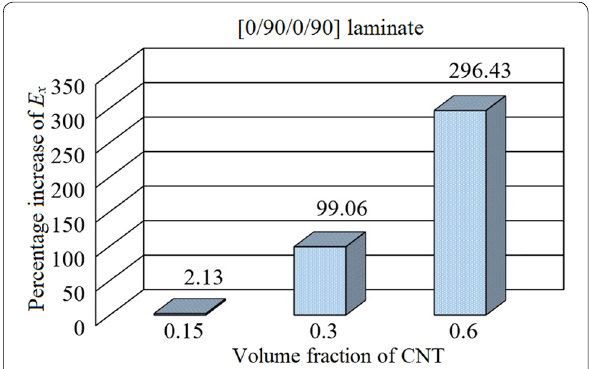
Fig. 6 Percentage increase in E x of CNT/epoxy with volume fraction as compared to CF/epoxy at a constant 60% CF volume fraction for [0/90/0/90] stacking sequence of laminate